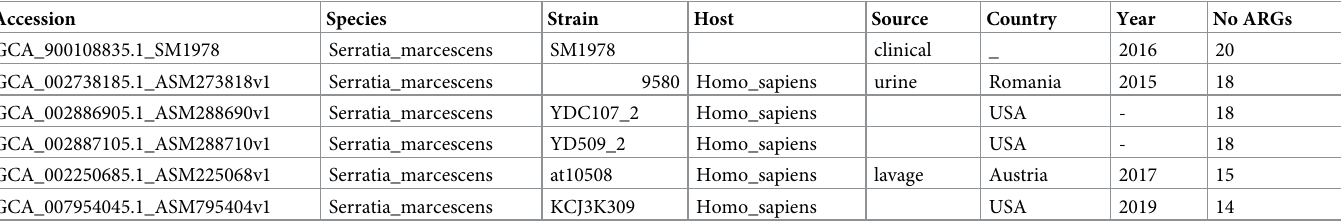
Table 6. Sequenced humans isolates of Serratia that are predicted to carry a IncHI2/IncHI2A plasmid, illustrating the rarity of the incompatibility group within this genus. Accession